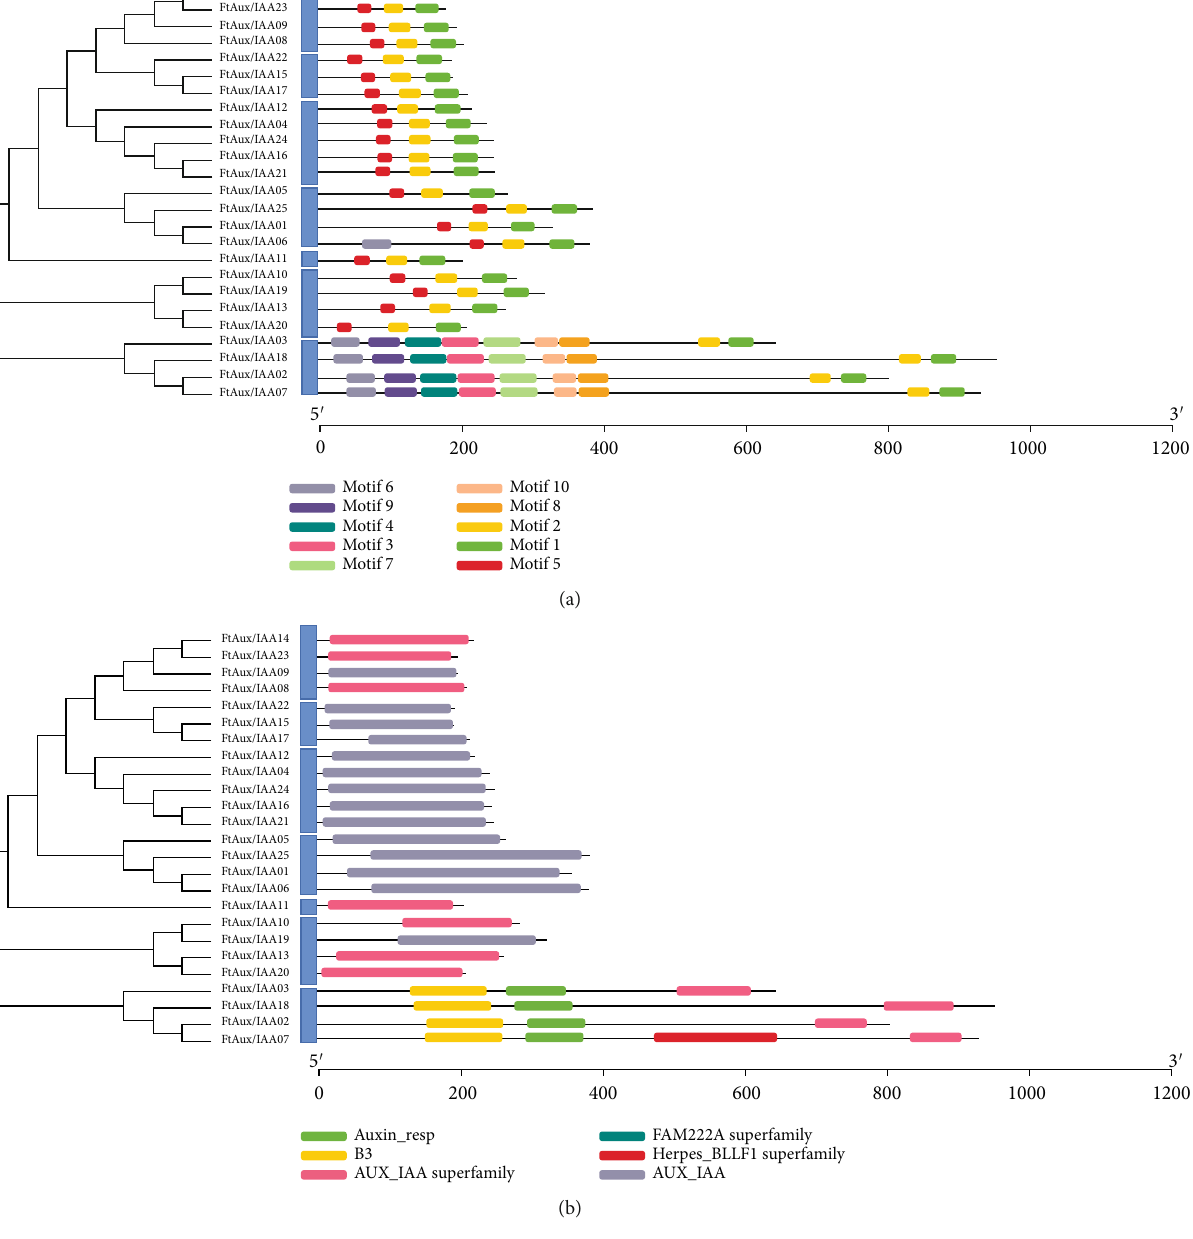
Figure 3: Gene motif pattern and gene domains in FtAux/IAA genes from Tartary buckwheat. (a) The protein domains of FtAux/IAAs are shown and are denoted by rectangles with di ff erent colors. (b) Gene domains with di ff erent functions are shown in di ff erent colored